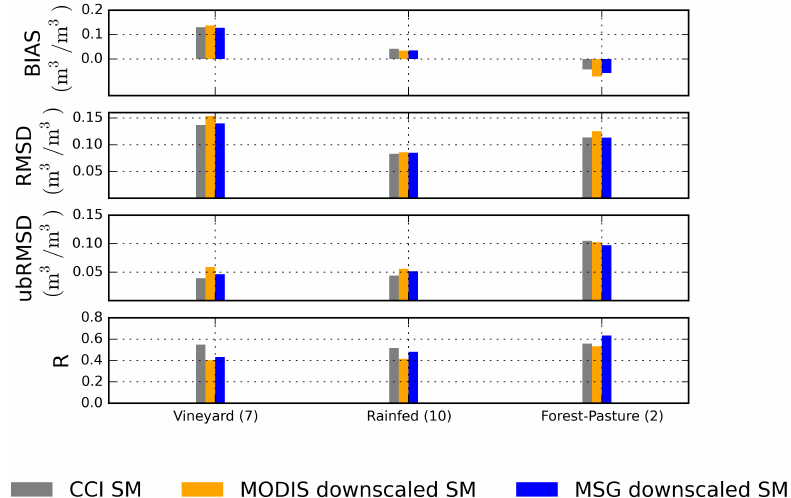
Figure 10. Bar plots for the comparisons between soils moisture estimates and in situ soil moisture per land use (vineyard, rainfed, and